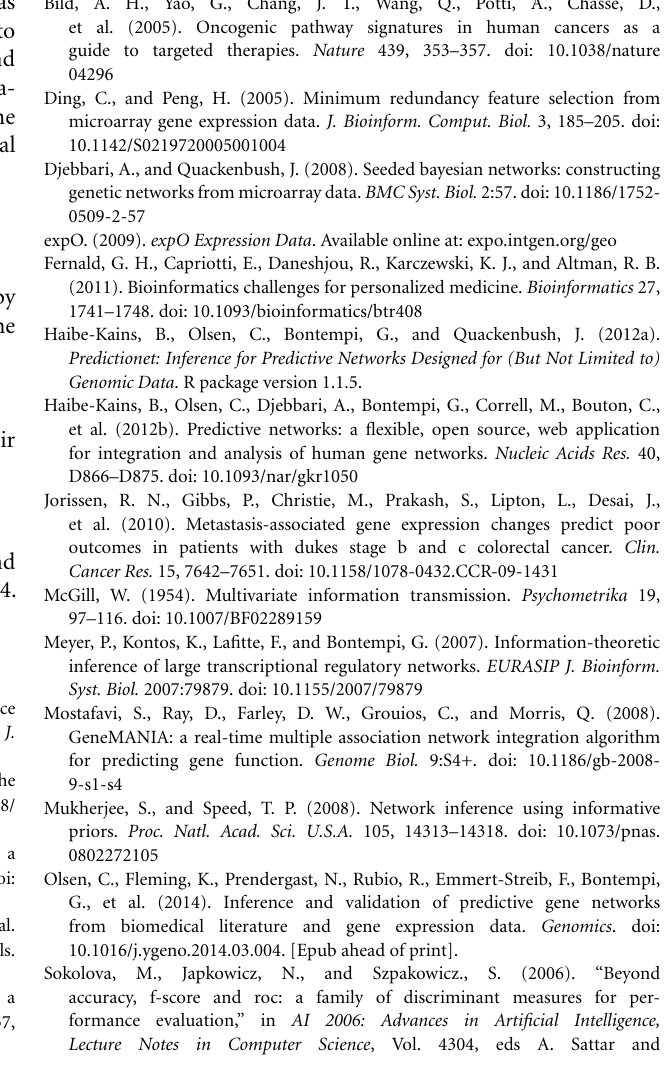
prior source was added. The x -axis specifies the prior source and includes ∗ if the F -score is significant with p -value < 0.05 and − for p -values <